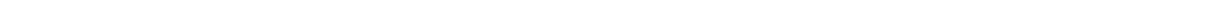
Fig. 4 Functional characterization of the DH domain. a Model for a complex of RhoA with the DH domain of Bcr-Abl. The GTPase binding model was inferred from the co-crystal structure of Dbs and RhoA (PDB ID 1LB1) upon alignment of the Bcr-Abl DH domain with the Dbs DH domain. The α 4 – α 5 loop in Bcr-Abl sterically clashes with RhoA in this model. b Representative SDS-PAGE analysis of the Ni-af fi nity pull-down experiment using His-tagged DH – PH or DH constructs and RhoA. The prey pull-down ef fi ciency is calculated from signal quanti fi cation normalized to the input and shown below the respective lane. I input, FT fl ow-through, W wash, E elution. c Summary of the pull-down ef fi ciency using either His-tagged DH – PH constructs or GST-tagged GTPases. d Chemical shift perturbation of E510 backbone NH during the NMR titration of the 15 N-labeled DH domain with increasing amounts of RhoA. e Binding af fi nities for interaction of the three GTPases RhoA, Rac1 and Cdc42 with the DH domain derived from fi tting the chemical shift changes with increasing GTPase concentration (Supplementary Fig. 6). Mean K d values ± s.d. are indicated. f Nucleotide exchange experiment for mant-GDP-loaded RhoA. The decrease of the fl uorescence was monitored in the presence of different Bcr-Abl DH – PH constructs and the Dbs DH – PH as a positive control. Experiments were done in duplicates at two different concentrations of the Bcr-Abl DH and DH – PH constructs. g Acceleration of the RhoA nucleotide exchange, i.e., the rate constant in the presence of a DH – PH construct compared to the RhoA intrinsic nucleotide exchange rate, plotted for the different DH – PH constructs at the respective concentrations. h , i Acceleration of Rac1 h and Cdc42 i nucleotide exchange for the different DH – PH constructs at the respective concentrations. Raw data are shown in Supplementary Fig.